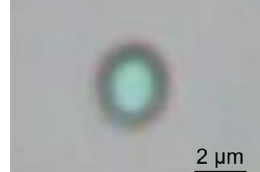
( b ) Figure 8. SEM images of T4 bacteriophage through the super thin ETM. ( a ) T4 bacteriophage on the ETM. ( b ) T4 bacteriophage through the super thin ETM. 4.2.3. Cyanobacteria in Liquid Figure 9 shows images of the cyanobacteria Synechocystis sp. PCC6803 in the culture